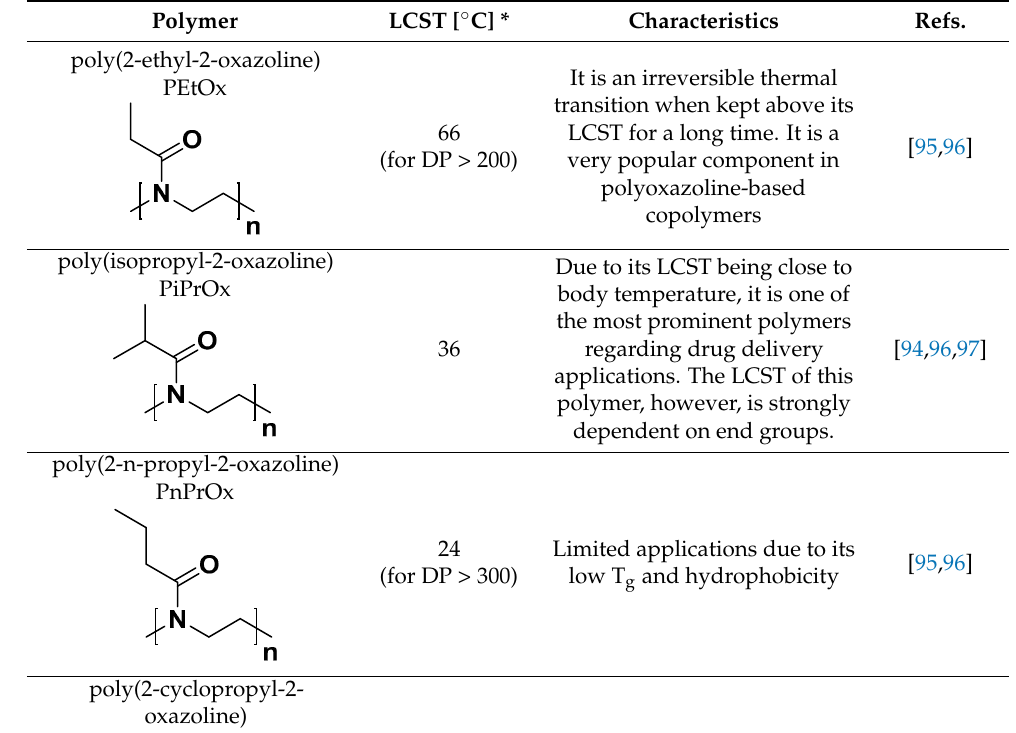
Table 2. The structures of thermo-responsive poly(2-oxazoline) homopolymers. Polymer